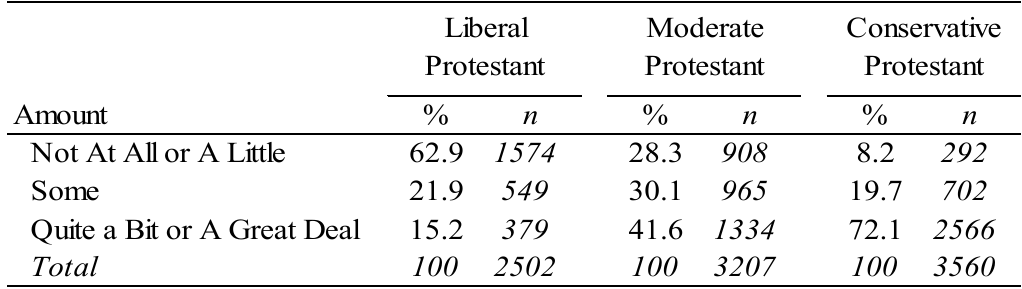
Table 2. Congregational Discourse on Abstaining from Premarital